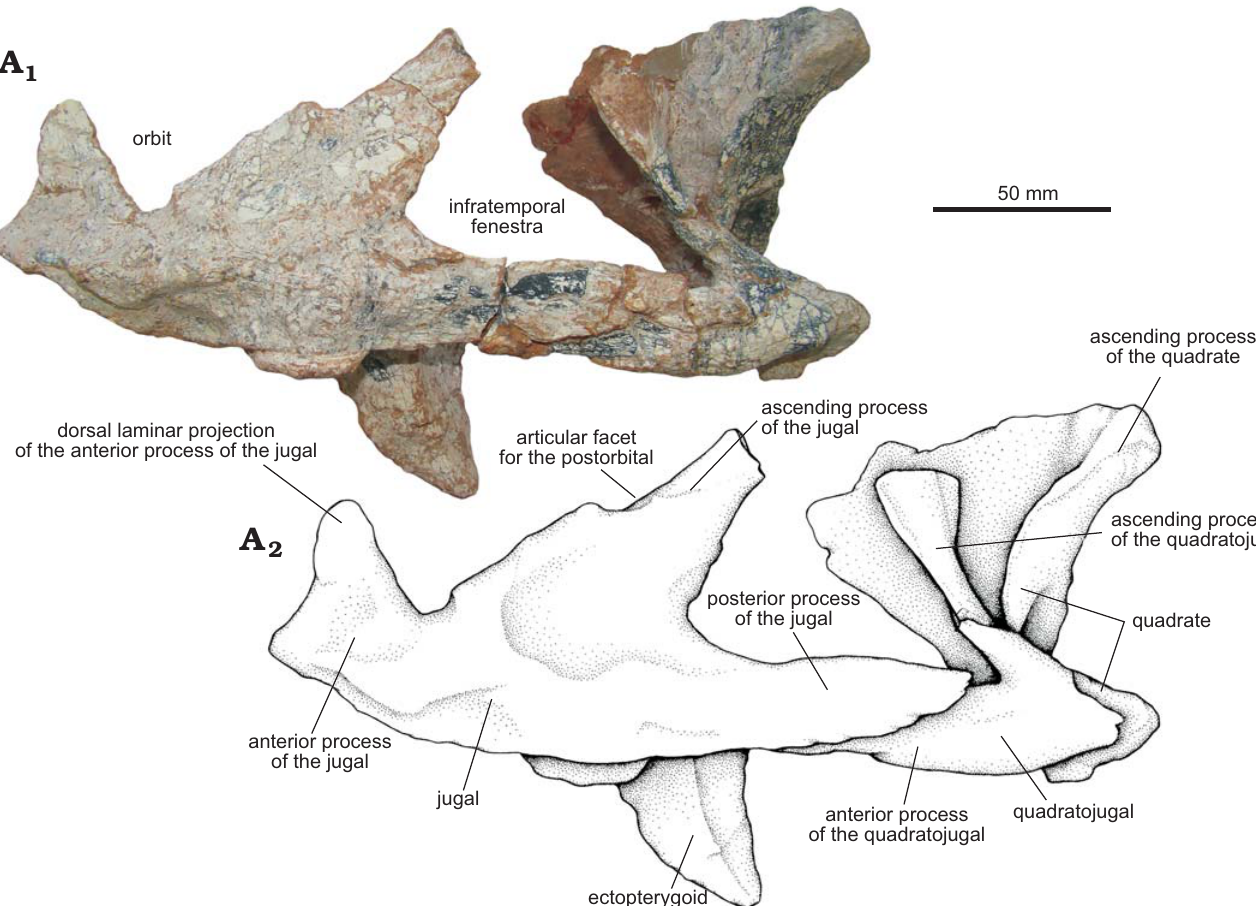
Fig. 13. The pseudosuchian archosaur Prestosuchus chiniquensis Huene, 1938 (UFRGS-PV-0629-T) from the Dinodontosaurus Assemblage Zone, Ladinian, Middle Triassic, Dona Francisca municipality, Rio Grande do Sul State, Brazil; left jugal, quadratojugal, and quadrate in lateral view. The articular condyle of the quadrate is broken. Photograph (A 1 ) and explanatory drawing (A 2